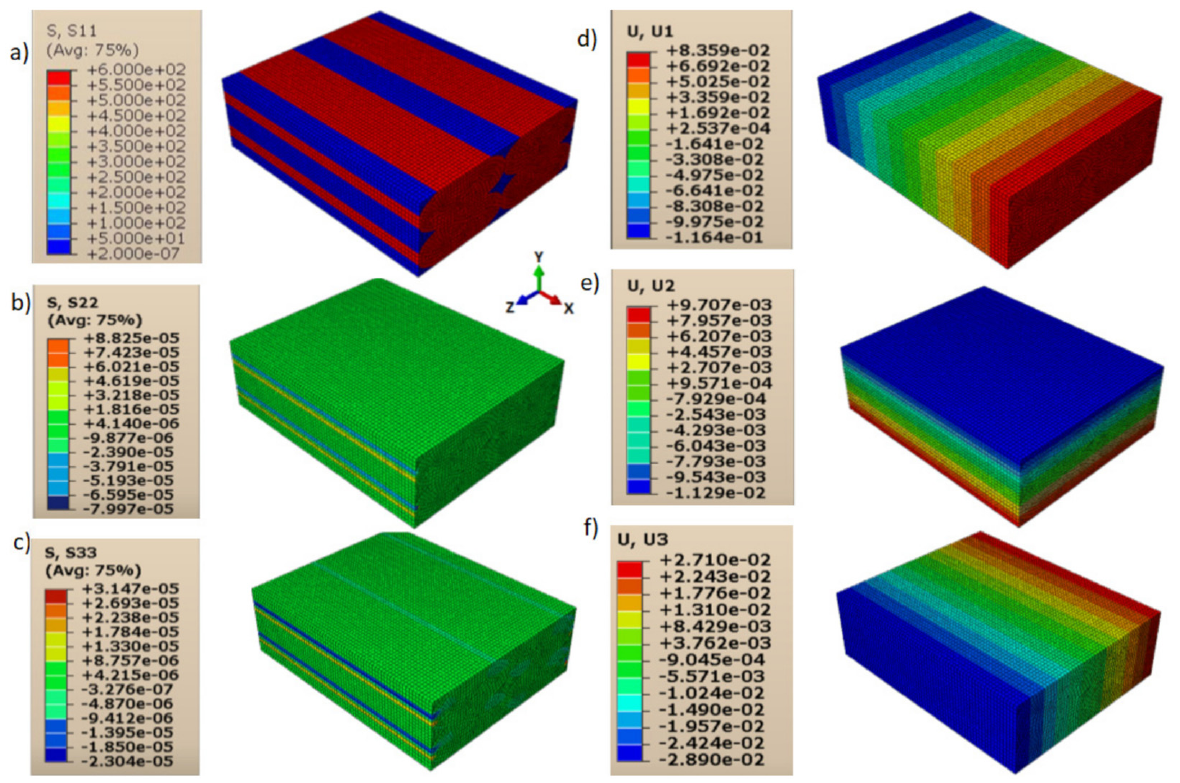
Figure 10. Load cases to evaluate E 11 : ( a ) stress in direction 11; ( b ) stress in direction 22; ( c ) stress in direction 33; ( d ) displacement in direction 11; ( e ) displacement in direction 22; and ( f ) displacement in direction 33.